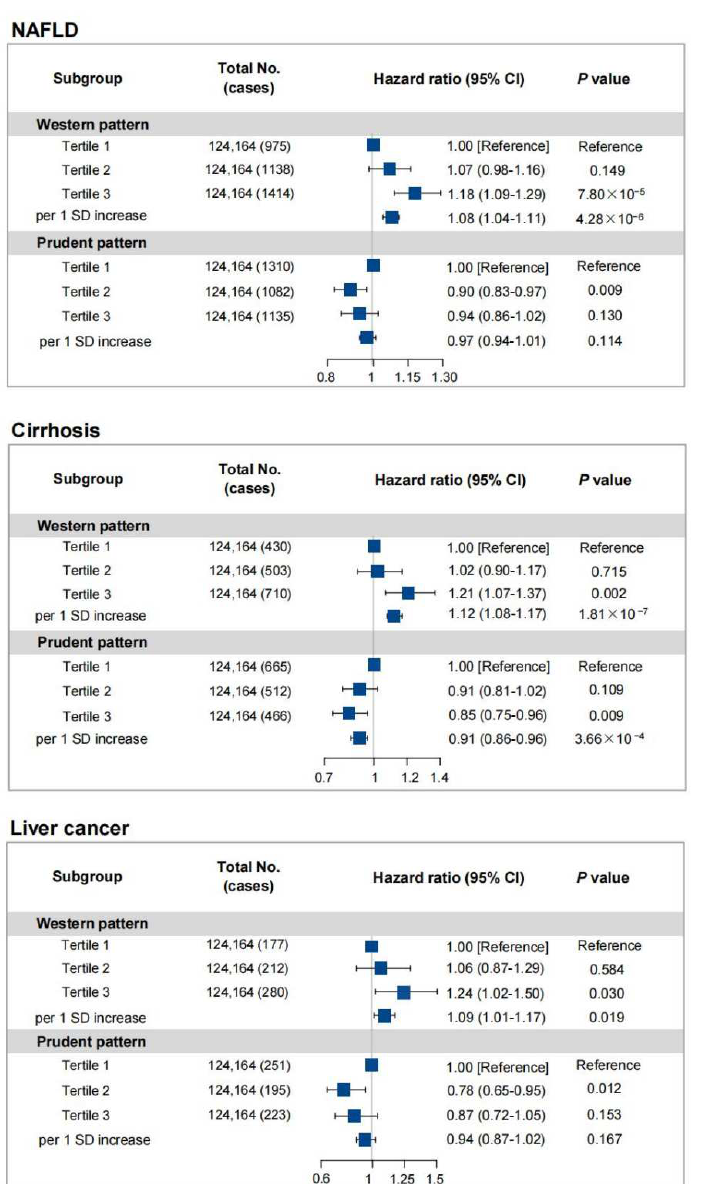
Figure 1. Hazard ratios for the risks of different liver diseases by dietary patterns (tertiles) in UK Biobank. HRs and 95% CIs were adjusted for age, sex, race, education level, Townsend deprivation index (quartiles), drinking status, smoking status, exercise, BMI, and diabetes. Definition of abbreviations: NAFLD, non-alcoholic fatty liver disease; HR, hazard ratio; 95%CI, 95% confidence interval; SD, standard deviation.